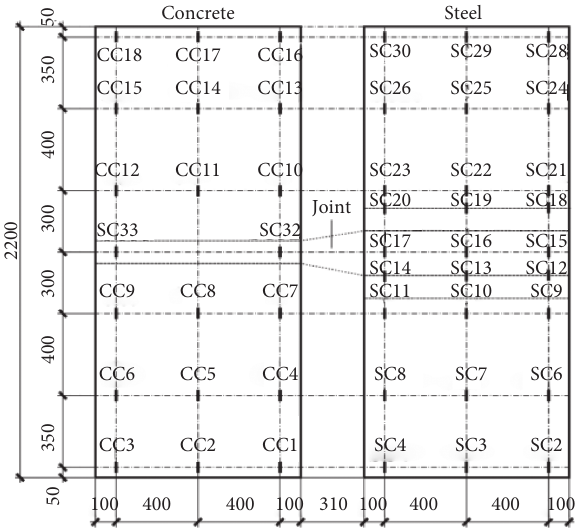
Figure 24: Arrangement of strain measuring points for jointed specimens in compressive